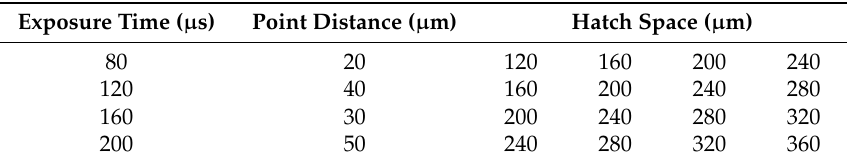
Table 3. Multi-layer fabrications of process